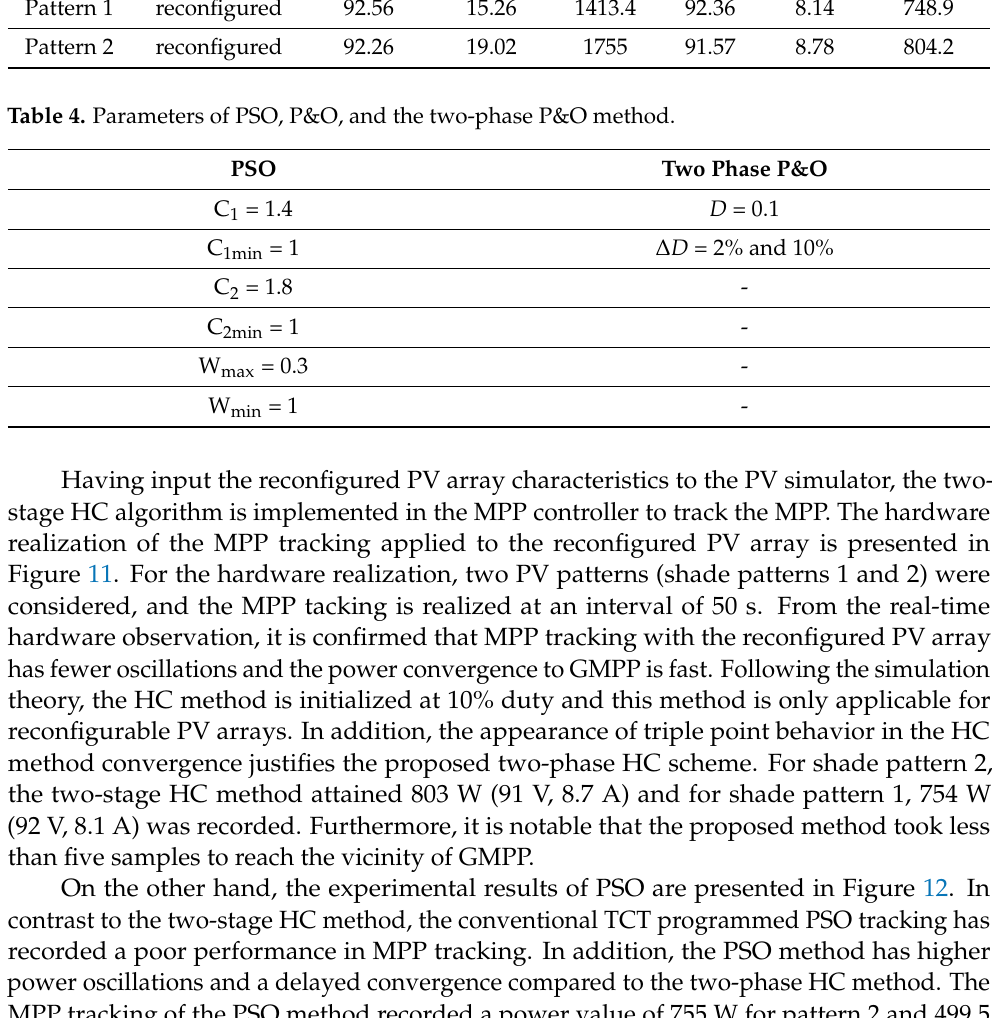
Table 3. Voltage, current, and power values for pattern 1 and pattern 2 in simulation and hard- ware models. 100 W—Simulation Model TCT/ S.No Reconfigured Pattern 1 TCT